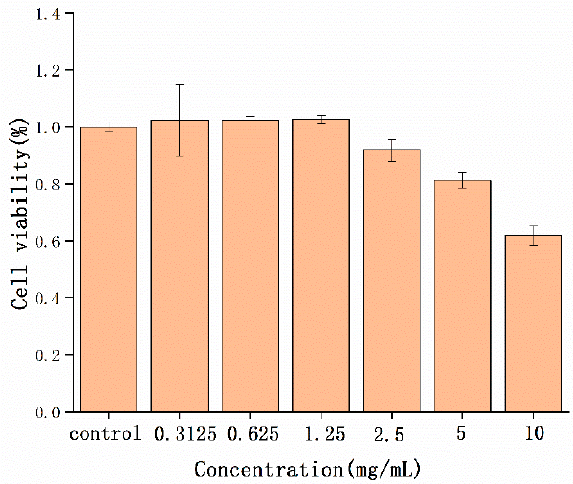
Figure 5. E ff ect of di ff erent concentrations of STC-NPs on the viability of RAW 264.7 Figure 5. Effect of different concentrations of STC ‐ NPs on the viability of RAW 264.7 cells.